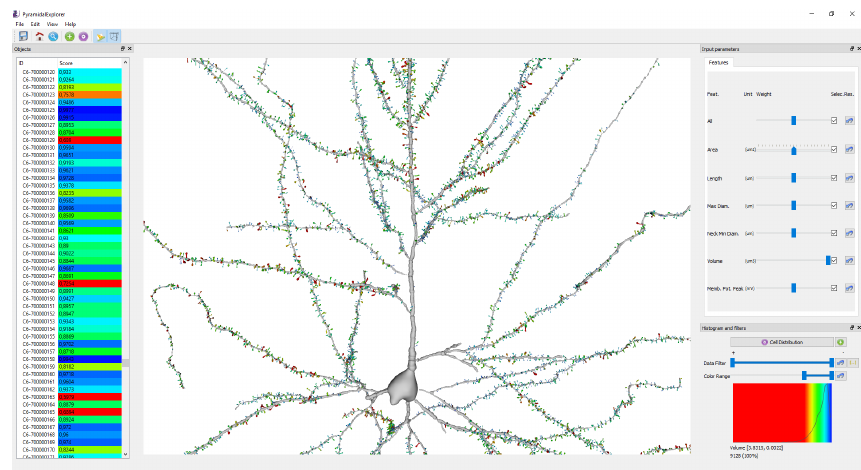
Figure 7. The PyramidalExplorer tool.